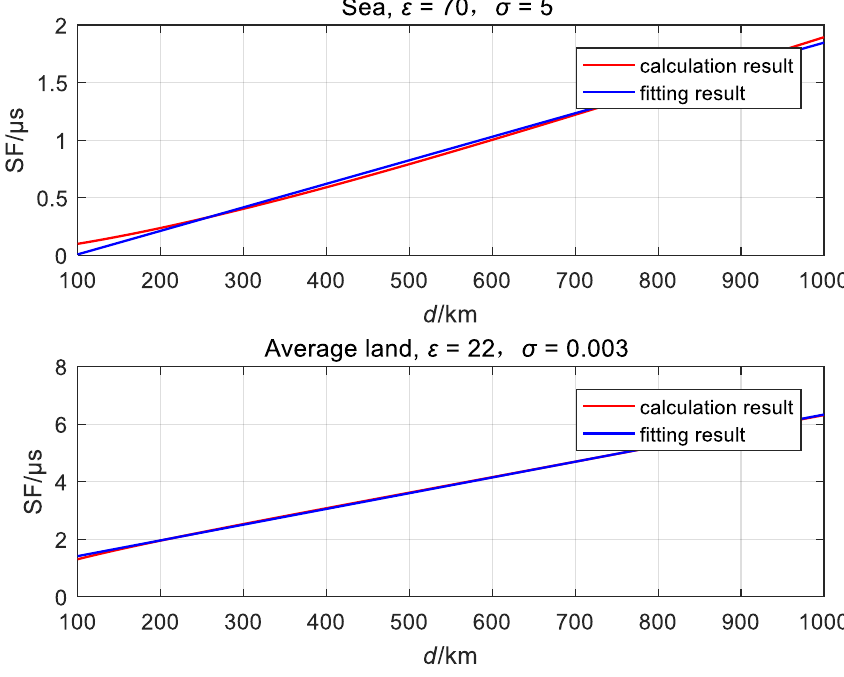
Figure 5. Fitting curve of seawater and average land.